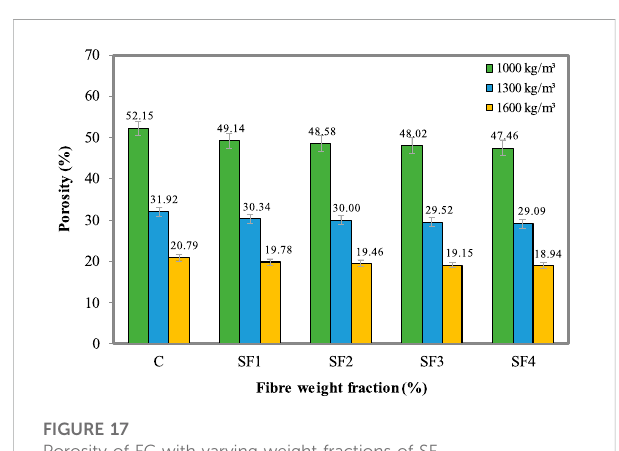
FIGURE 17 Porosity of FC with varying weight fractions of SF.